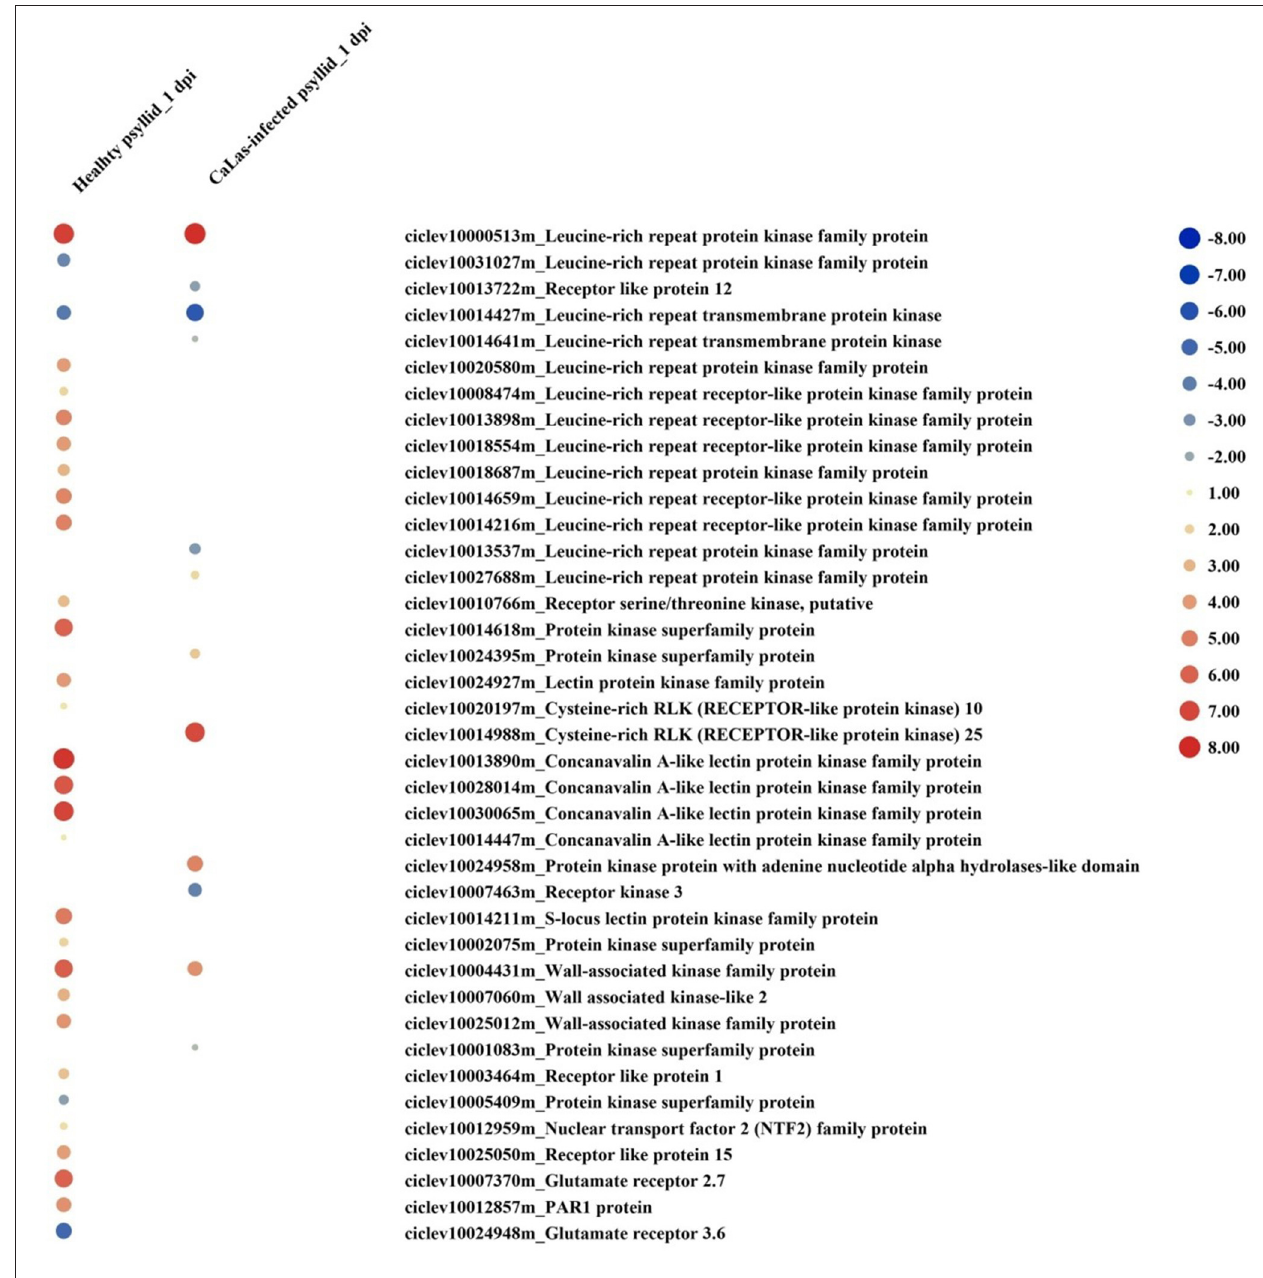
FIGURE 4 | The red-blue heatmap of modulated DEGs involved in “signaling receptor” pathways. Each DEG is depicted by a color signal where red signifies upregulation and blue signifies downregulation. The size of each spot indicates the level of expression.